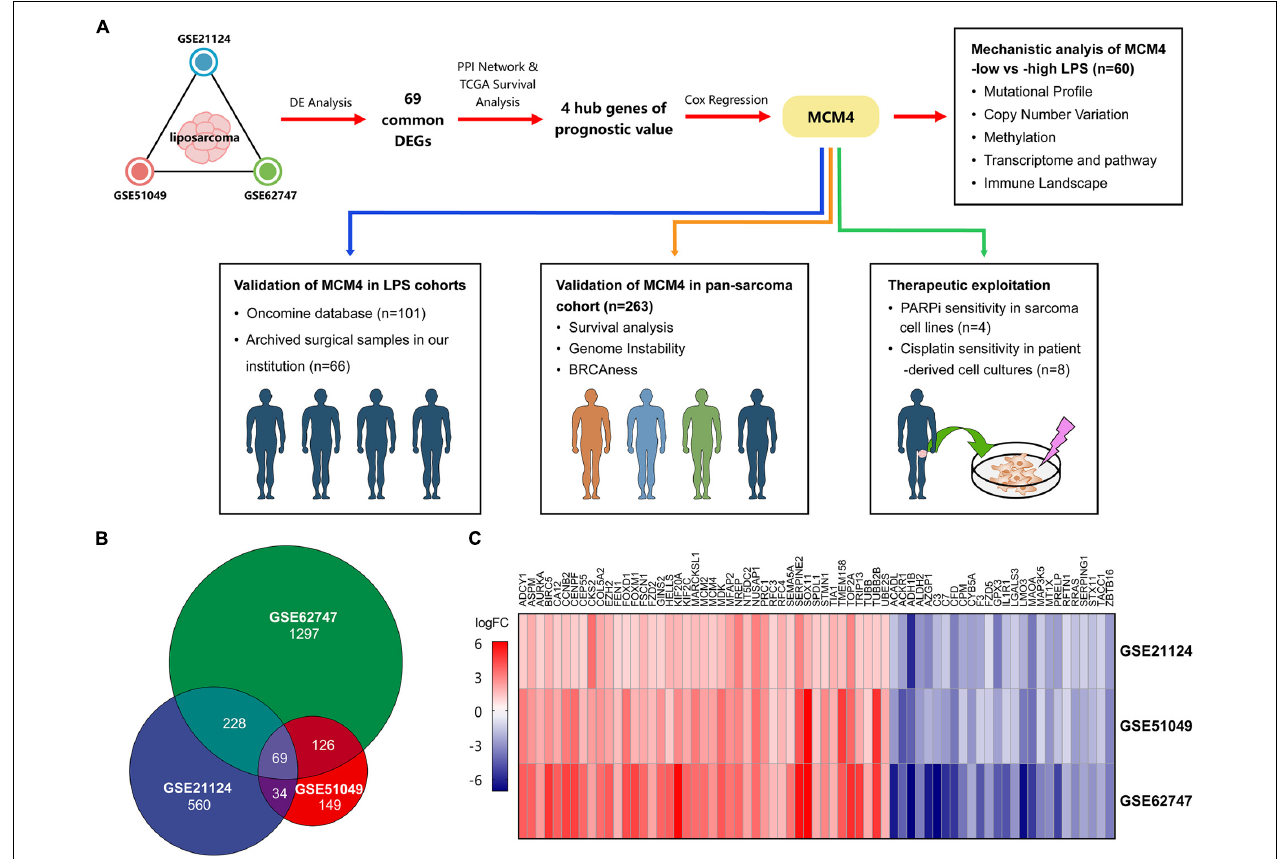
FIGURE 1 | The overall study design and the identification of the potential biomarkers. The schematic graph represents the overall design of the study. Mini-chromosome maintenance protein 4 (MCM4) was prioritized from multiple Gene Expression Omibus (GEO) datasets, and validated in liposarcoma (LPS) and pan-sarcoma cohorts. The therapeutic potential of the MCM4-high expression subgroup was explored in cell lines and patient-derived tumor cell cultures (A) . A total of 69 common differentially expressed genes (DEGs) among three datasets of LPS (B) , with the corresponding gene expression level shown in the heatmap (C)